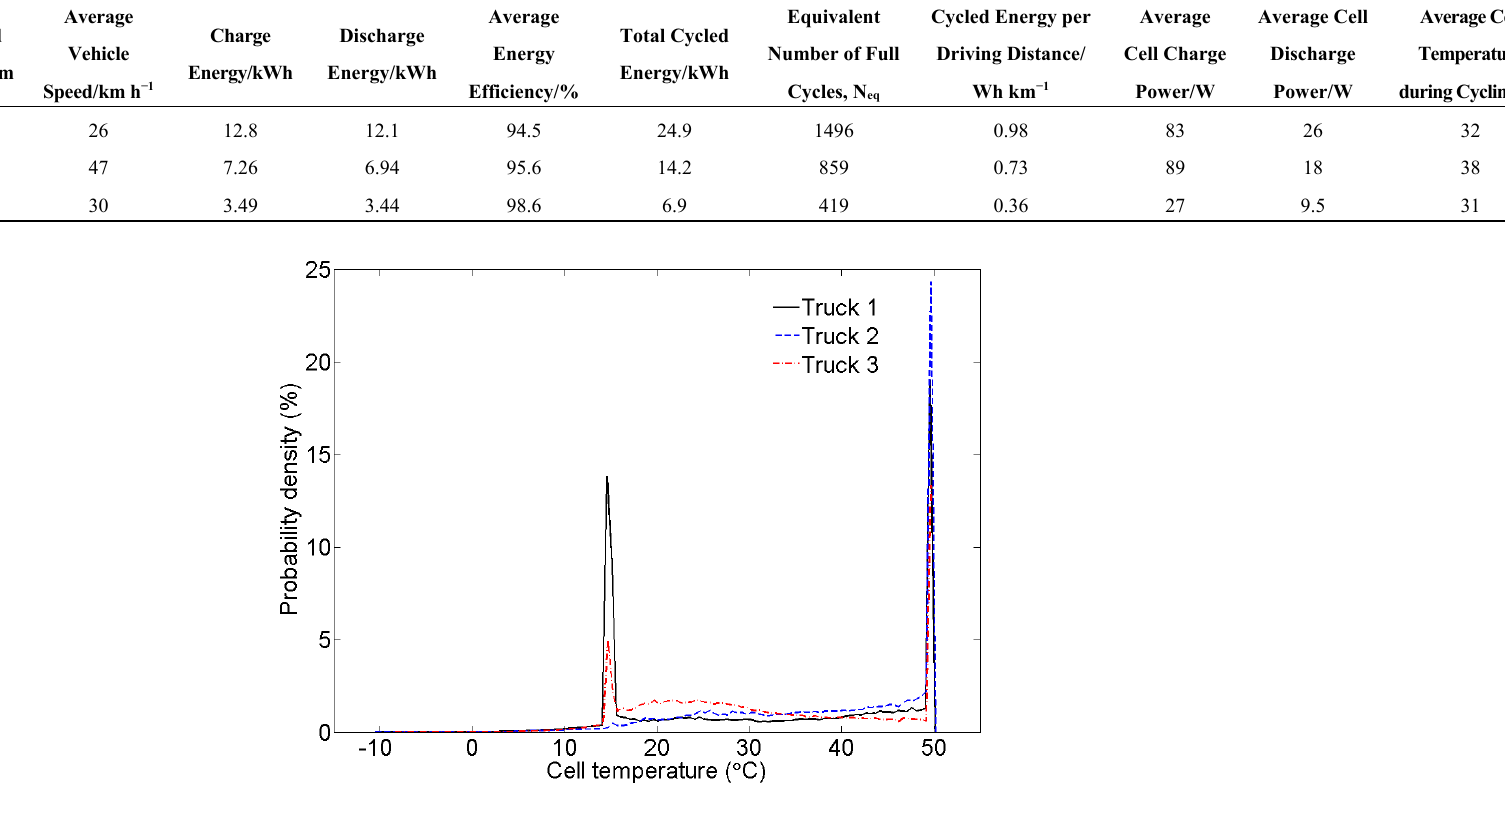
Figure 3. Distribution plots for the complete test period showing cell temperatures (the reference cells have the same distributions at the cycled cells, resolution 0.5